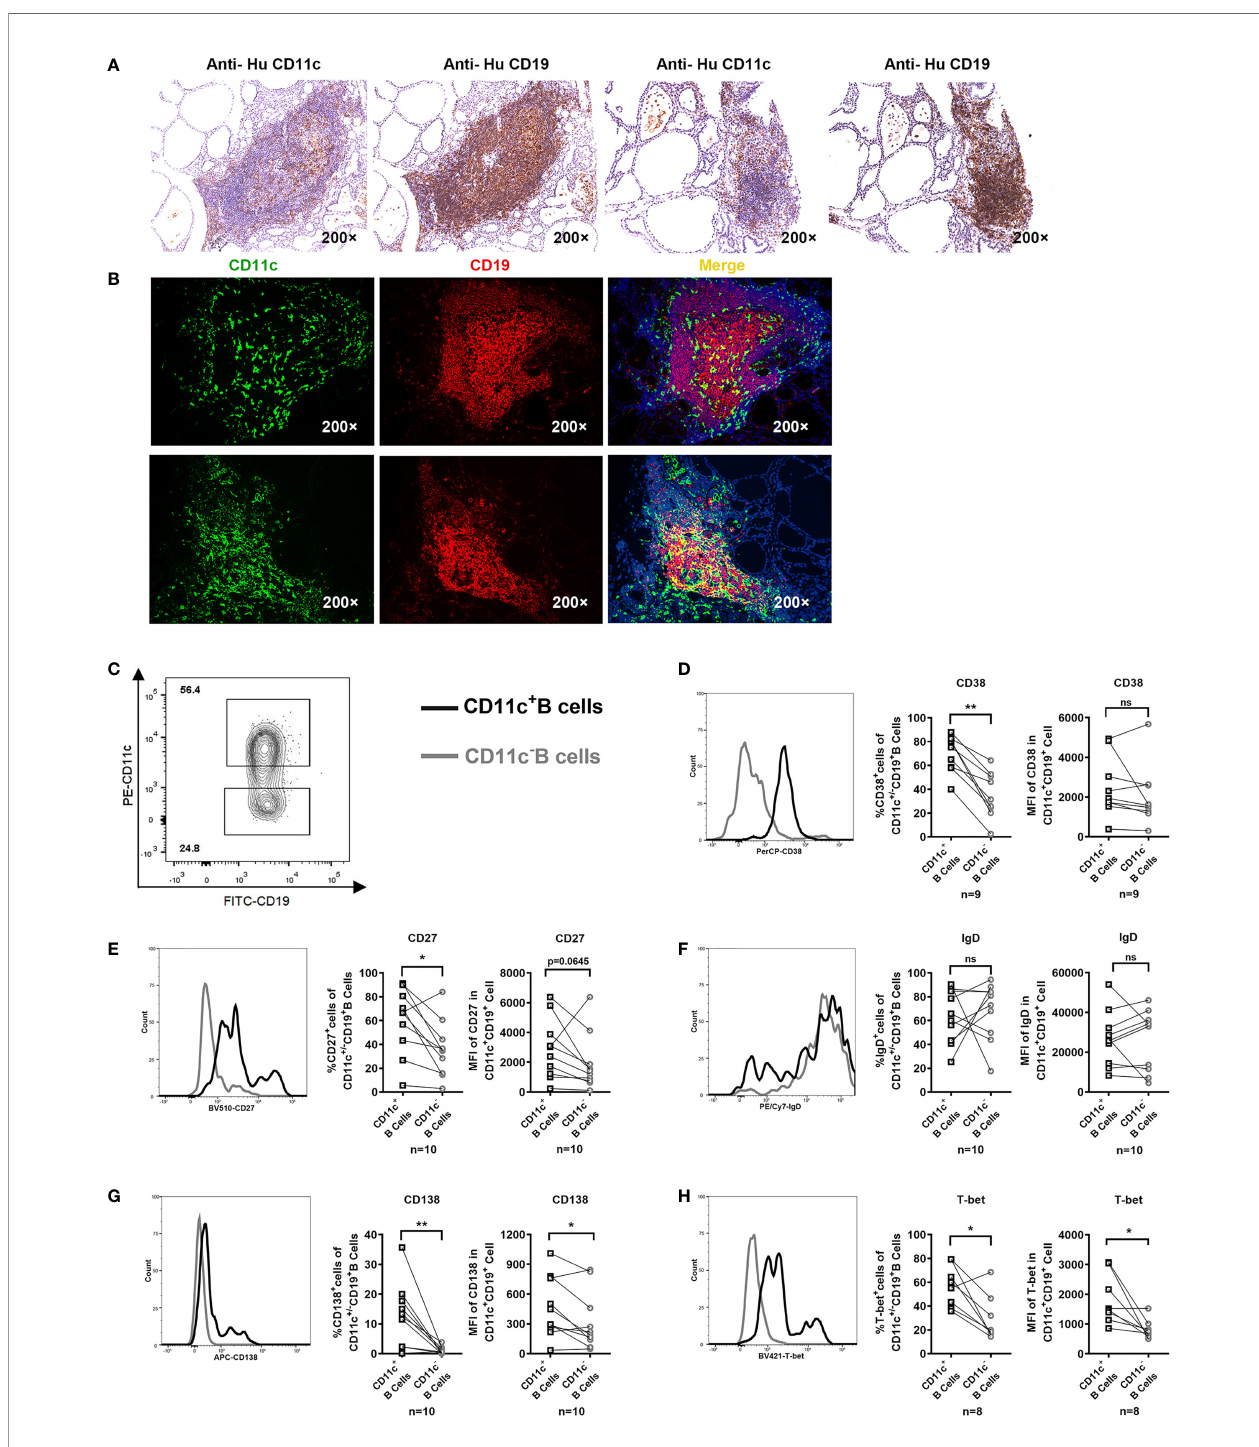
FIGURE 5 | CD11c + B cells in the thyroid of GD patients and phenotypic analysis. (A) Immunohistochemical staining for CD11c and CD19 in serial sections of thyroid tissue from two GD patients (200-fold magni fi cation). (B) Immuno fl uorescence staining for CD11c (green) and CD19 (red) and DAPI (blue) in thyroid sections (200-fold magni fi cation) from two GD patients. (C) Representative fl ow cytometric plots of paired CD11c + B cells and CD11c - B cells in FNA samples from GD patients. (D – H) Comparative overlapped histograms of FNA example in CD11c + B and CD11c - B cells for compared markers (left). Comparison between the frequency of positive cell populations in CD11c + B cells and that in paired CD11c - B cells in FNA samples (middle). Comparison between the mean fl uorescence intensities (MFIs) of the representative phenotype in CD11c + B cells and those in paired CD11c - B cells in FNA samples (right). The comparison metrics included conventional antigens (CD38, CD27, IgD, and CD138) and an unconventional antigen (T-bet). Data were compared between two groups with a paired Student ’ s t test. P < 0.05 was considered statistically signi fi cant. ns, no signi fi cance; * P < 0.05; ** P <